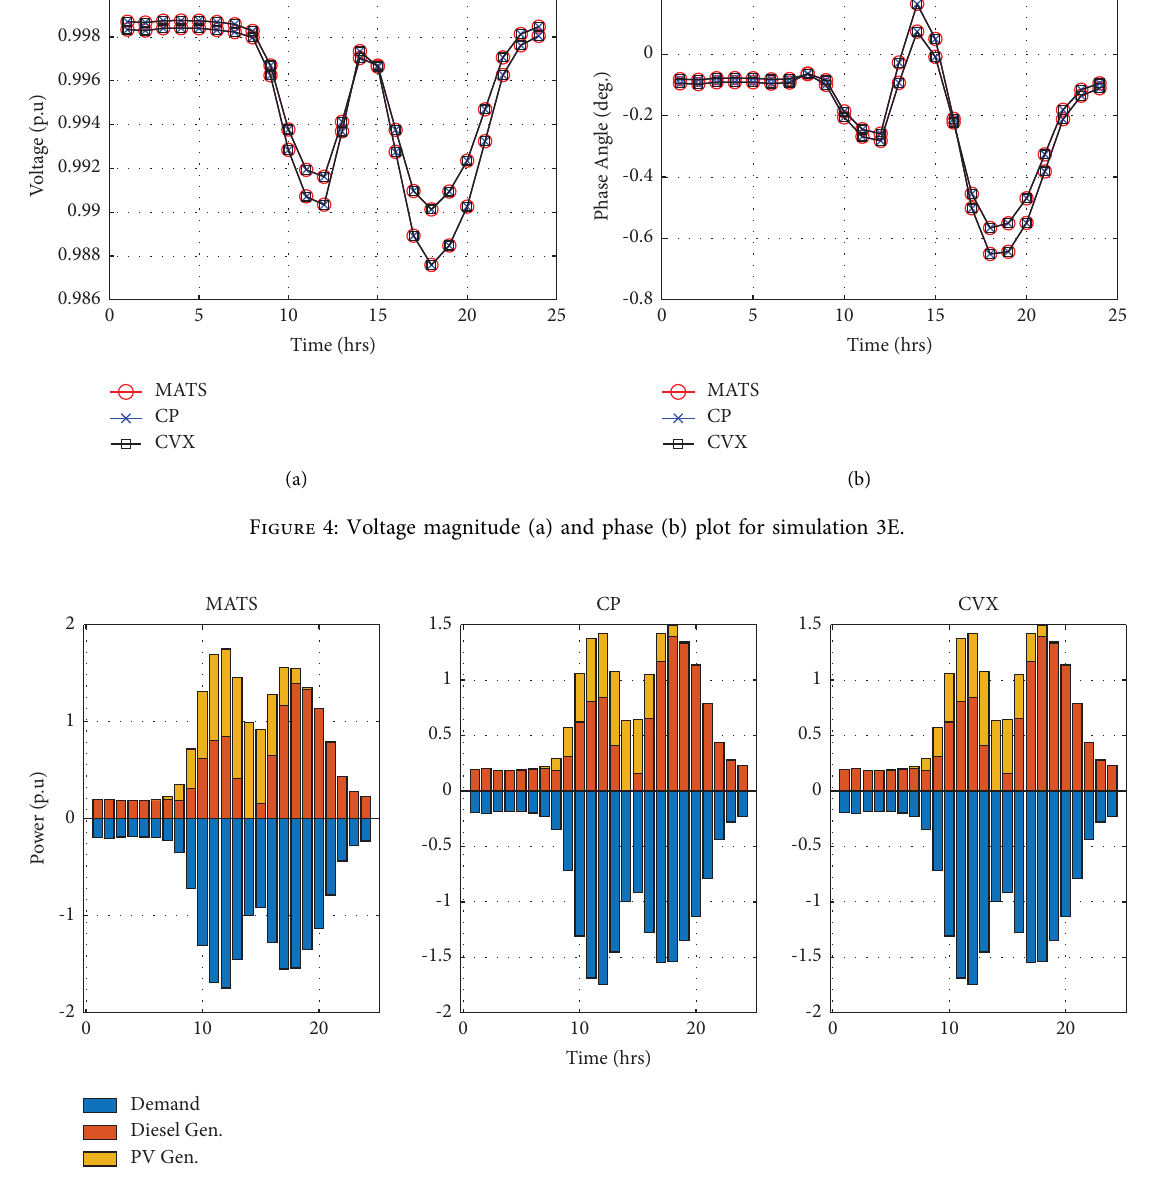
Figure 5: Power balance for simulation